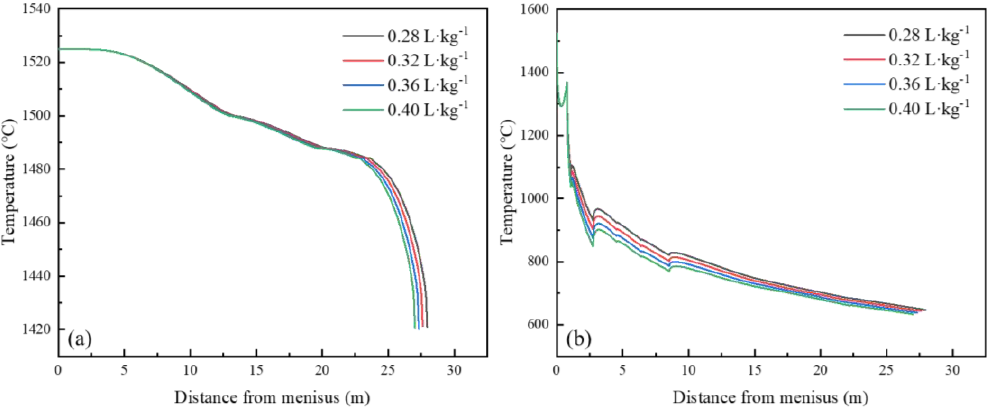
Figure 9. Surface and center temperature curves of casting slab under different specific water flow: ( a ) center temperature; ( b ) surface temperature.